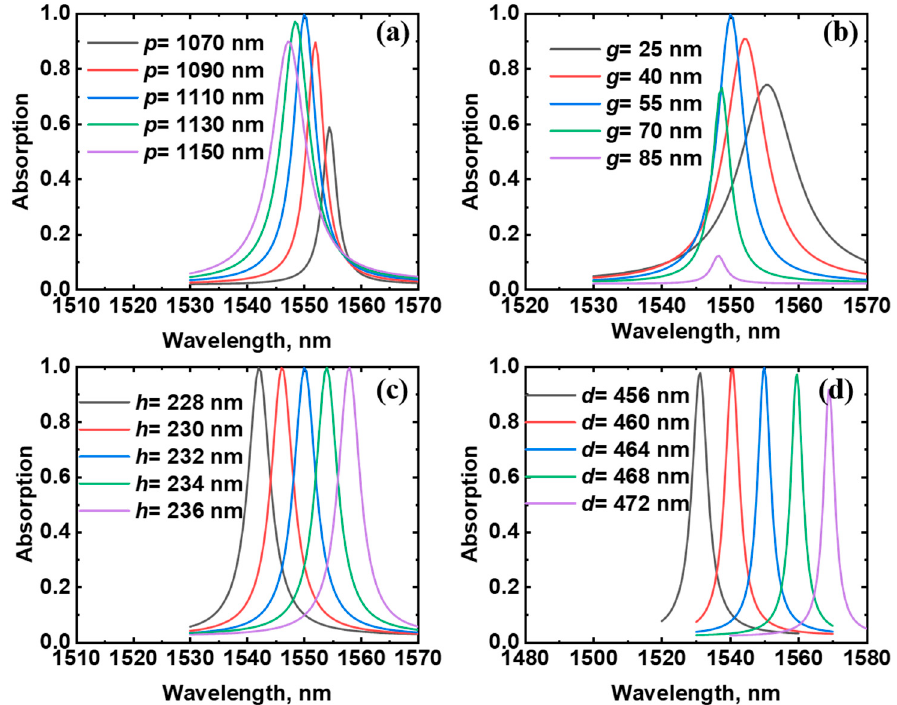
Figure 6. Absorption spectra for various geometrical parameters: ( a ) period p , ( b ) gap distance g , ( c ) thickness of a-Si disk h and ( d ) diameter of a-Si disk d .